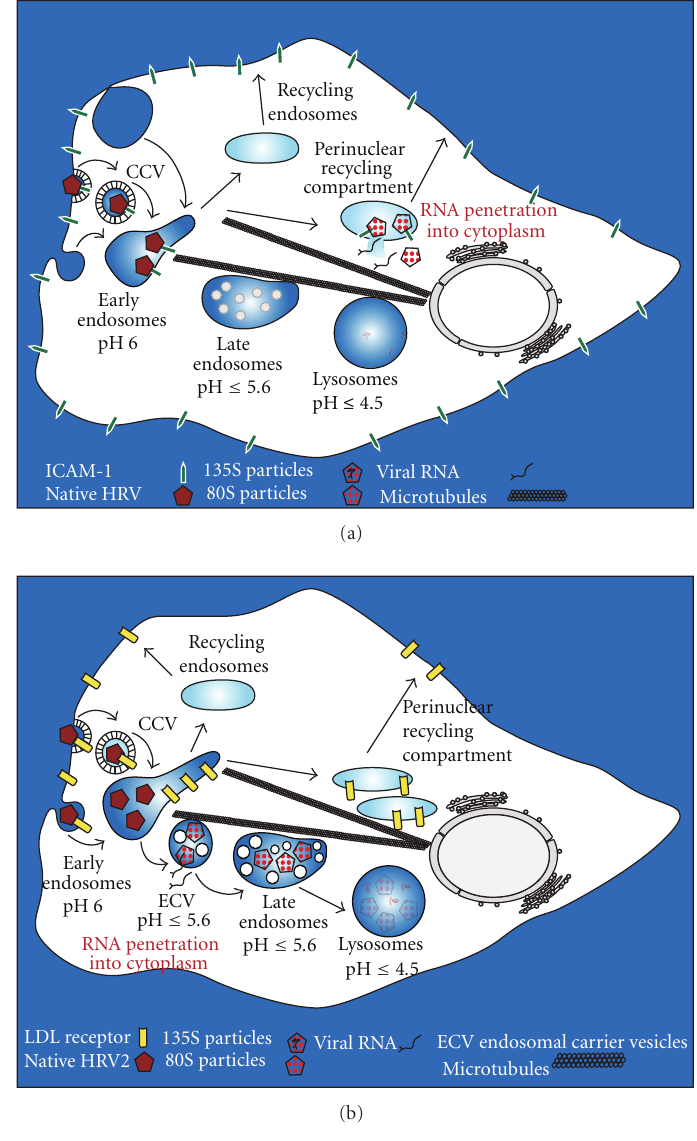
Figure 3: Entry, intracellular tra ffi cking, and uncoating of HRVs in HeLa cells. (a) The major group virus HRV14 is internalized via clathrin-mediated endocytosis and delivered into early endosomes from where it presumably further tra ffi cs into the perinuclear recycling compartment. Structural modification of the viral capsid catalyzed by ICAM-1 is probably coupled to RNA release and rupture of the endosomal membrane. These events lead to delivery of free RNA and empty capsids into the cytoplasm. Most likely, uncoated virus and the RNA escape from the perinuclear recycling compartment. (b) HRV2 enters via clathrin-dependent and independent pathways and dissociates from its receptors at mildly acidic pH in early endosomes. Receptors are recycled and HRV2 is transferred to ECV/late endosomes where the more acidic pH ( ≤ 5.6) induces the structural modification resulting in uncoating and RNA transfer into the cytosol. Finally, residual native virus, subviral particles, and viral RNA are transported via late endosomes to lysosomes where they are degraded. Adapted from Fuchs and Blaas [112]. Note that the pathways might di ff er in other cell